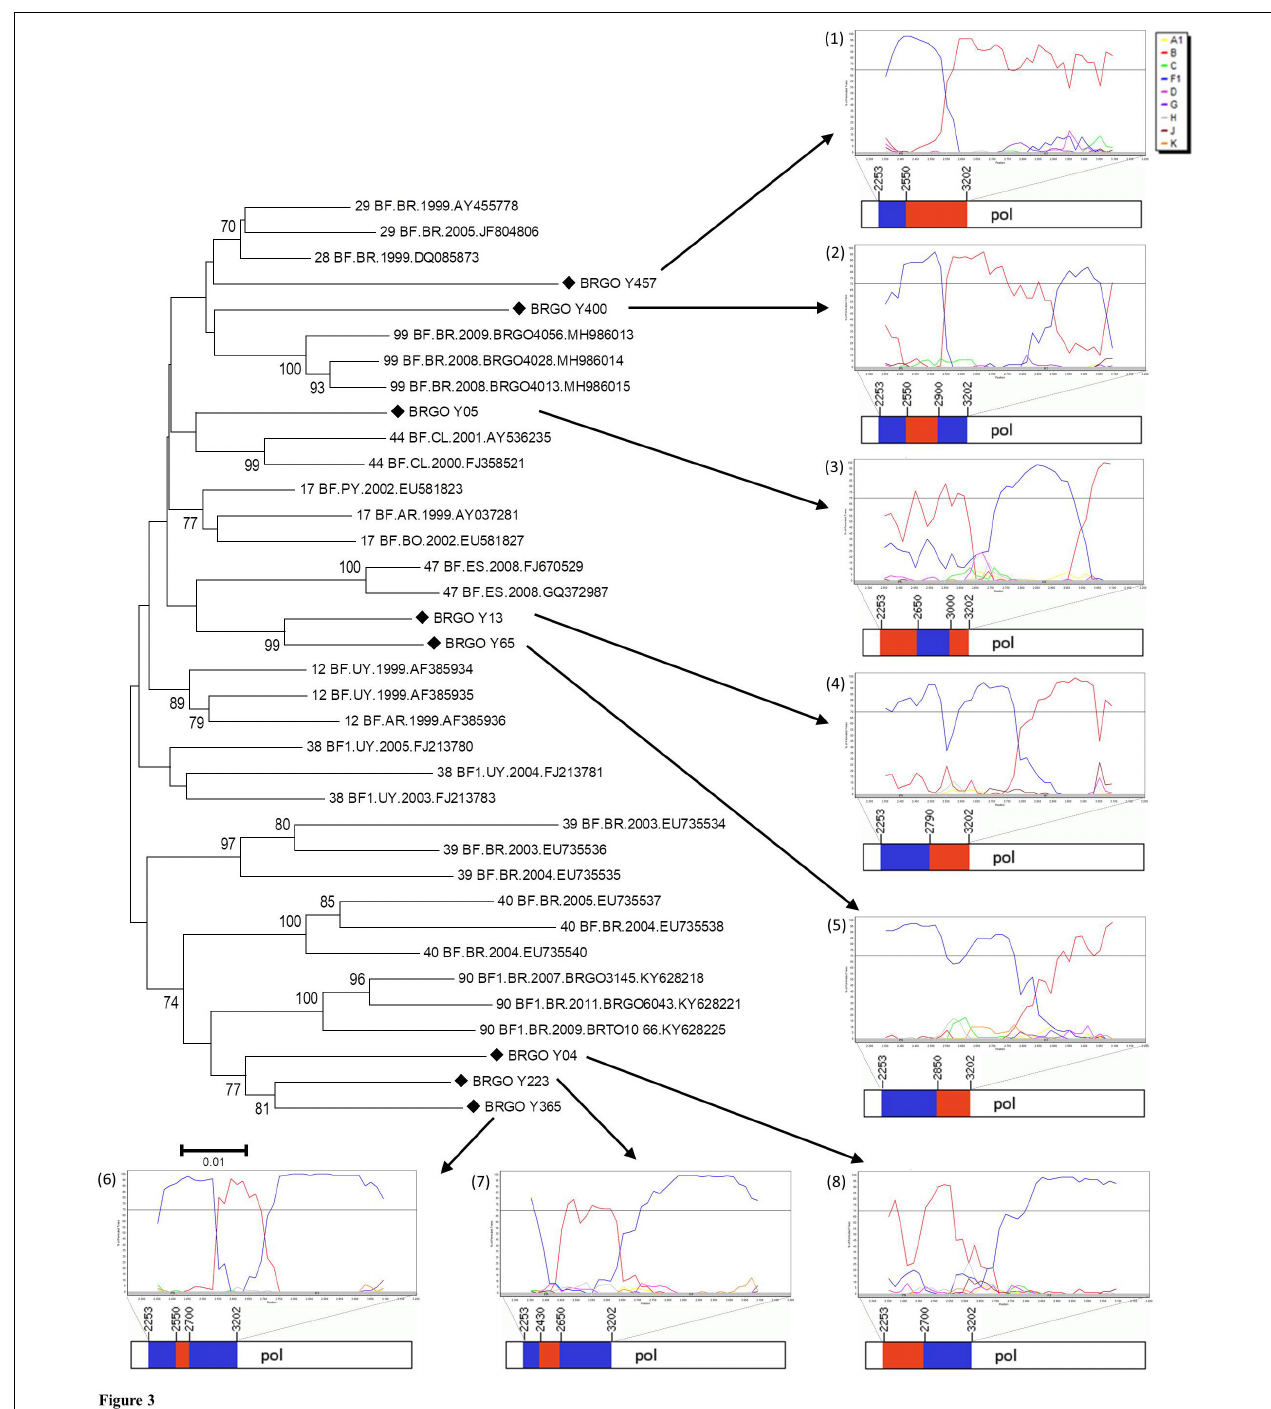
FIGURE 3 | Phylogenetic analyses of eight HIV-1 pol sequences of BF1 recombinants among men who have sex with men (MSM) from Central-Western Brazil. All CRF_BF depicting recombination breakpoints in pol gene were included in the analysis. The sequences described in our study are distinguished from the sequences retrieved from the Los Alamos HIV Database by a diamond signal ( (cid:7) ). The NJ method and Kimura two-parameter evolutionary model with 1,000 replicates bootstrap values were applied. The numbers from (1) to (8) represent the Simplot Bootscan analysis and the mosaic structures containing the breakpoint positions of each recombinant. Bootscan analysis was performed in a 200-nt sliding window advanced in 20-nt step size increments (1,000 bootstrap replicates), where the red color stands for subtype B, blue stands for subtype F1. In the mosaic structure representations of BF1 isolates, the breakpoint positions are indicated according numeration to HIV-1 genome position; the red color stands for subtype B, and blue stands for subtype F1.